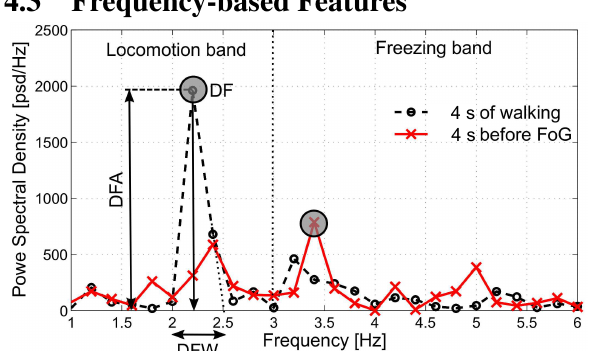
Figure 4: The acceleration’s power spectral density between [1, 6] Hz, from a 4-second window just prior to FoG, and from a 4-second window during mere walking, from the same prior-to-FoG session. The three frequency features are different just prior to FoG, compared with walking: DF migrates to [3, 8] the relation width-amplitude increases prior to